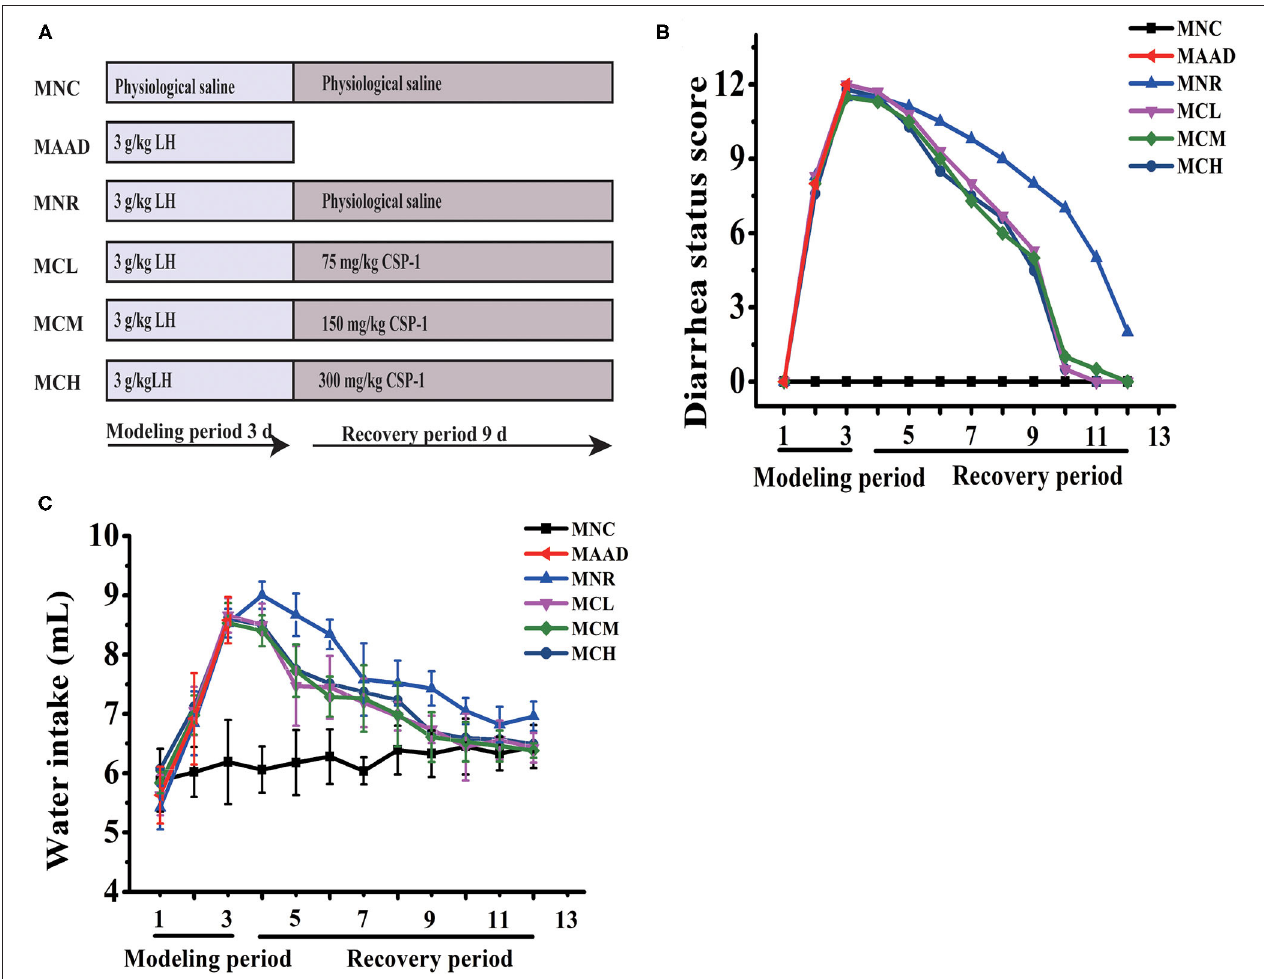
FIGURE 1 | Schematic diagram in the experiment (A) ; Changes of diarrhea status score and water intake (B,C) . Values are shown as means ± SD.